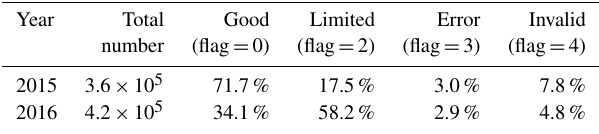
Table 7. Relative amount of available 4s data points (here NO x ) with respect to its validation flag for all flights in 2015 and